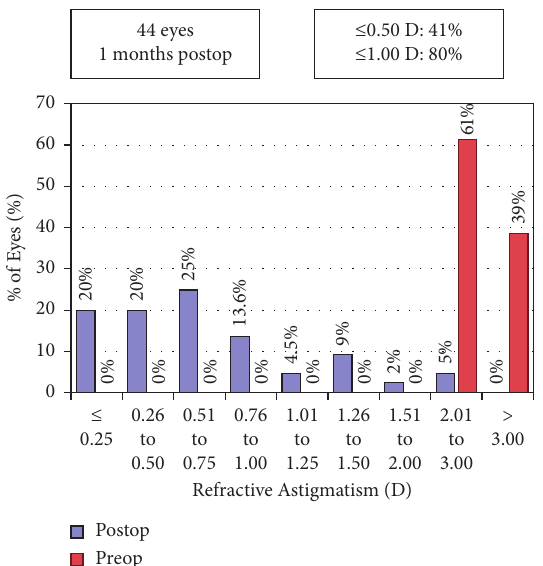
Figure 1: Pre and postoperative refractive astigmatism by percent.